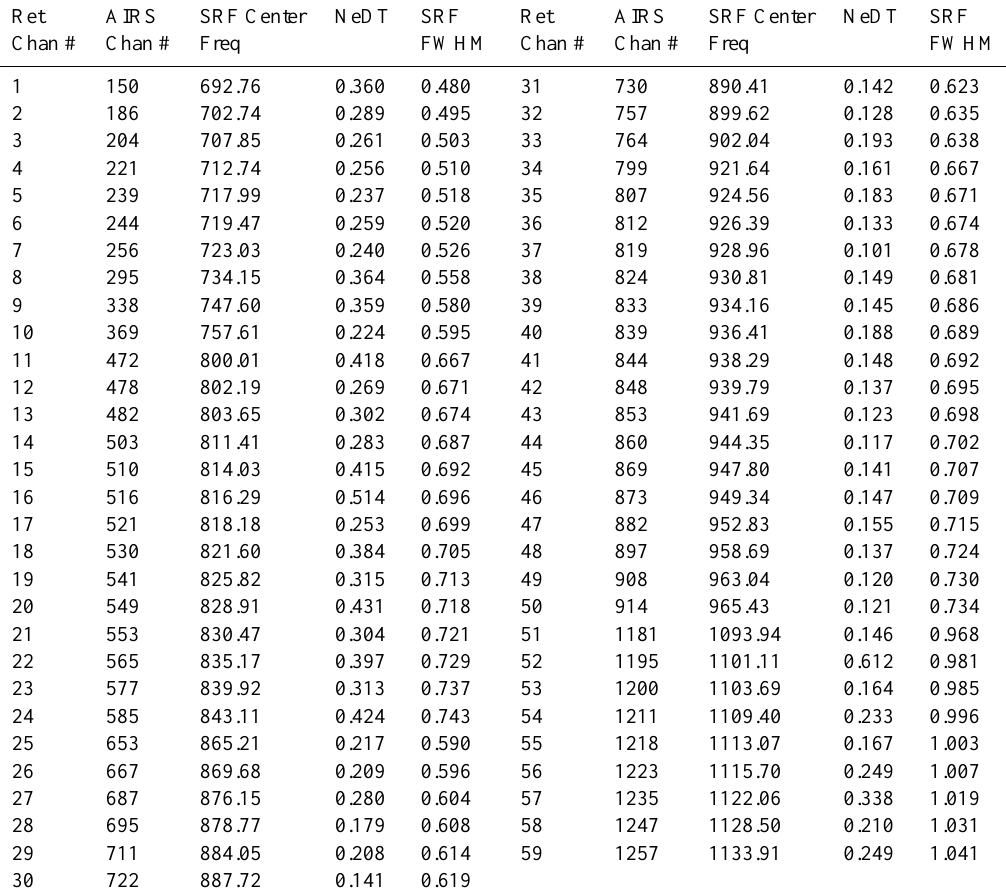
Table C1. A list of the AIRS channels used in the retrieval (out of a total of 2378). The noise-equivalent delta temperature (NEdT) is reported in Kelvin for a scene T b of 250K. The center of the channel spectral response function (SRF) and the full width at half max- imum (FWHM) of the SRF are both reported in wave numbers (cm − 1 ) . These data are taken from the AIRS channel properties